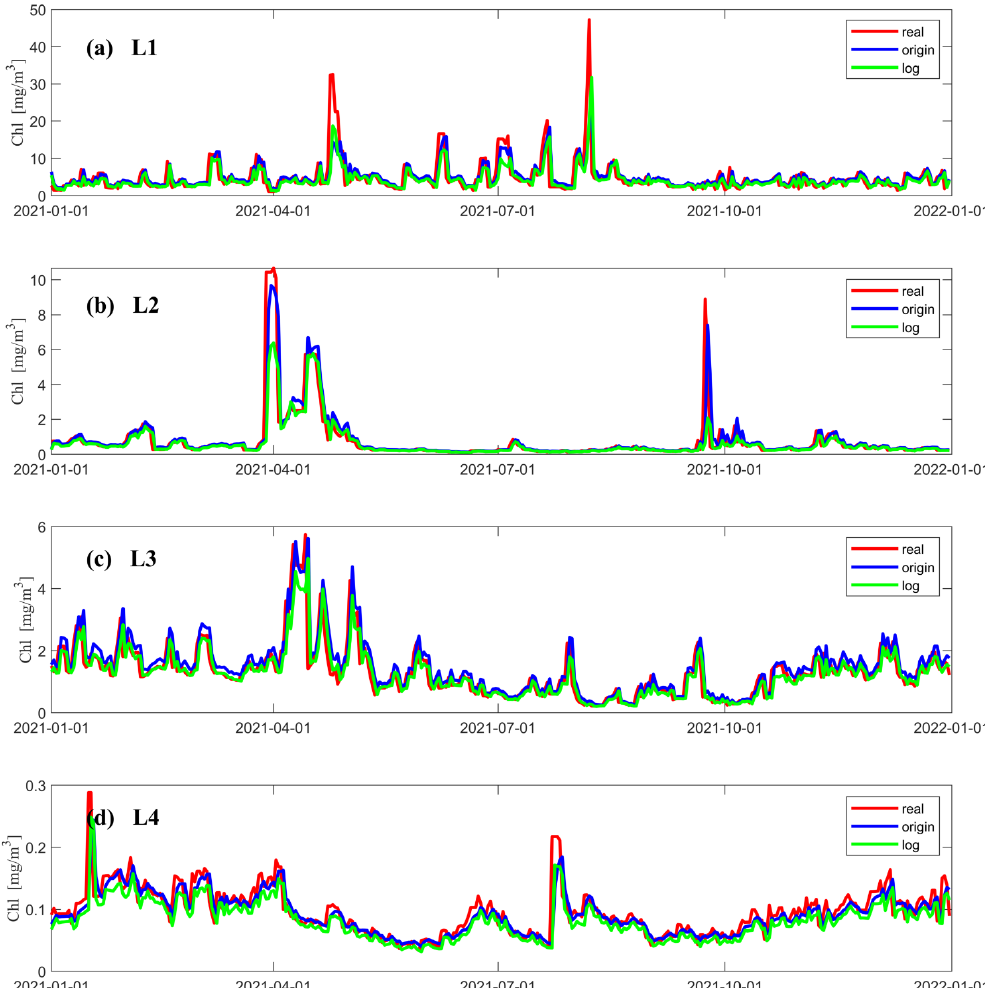
Figure 4. Chl-a data from satellite observations at different points and the results predicted by LSTM models using two different data processing methods, where the red solid line shows the data from satellite observations, the blue solid line shows the result data predicted using the original data as the input to the neural network, and the green solid line shows the results predicted using the logarithmic data as the input to the neural network. ( a – d ) show comparison of prediction results with satellite observations for each of the four points in 2021. The vertical coordinate is the Chl-a concentration, and the horizontal coordinate is the number of